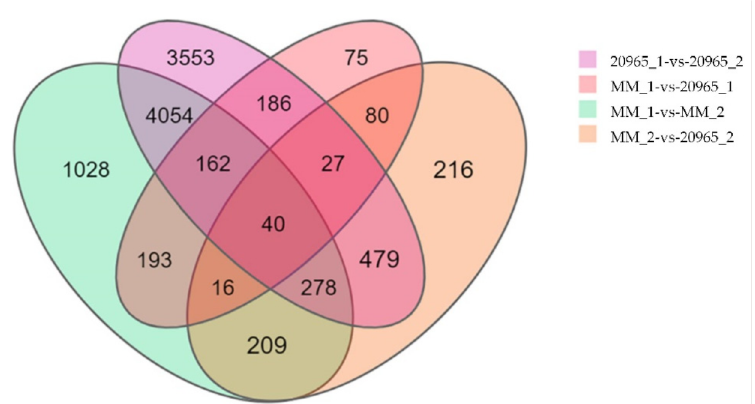
Figure 3. Venn diagram of DEGs included in the four groups. The four groups are MM_1-vs-MM_2, 20965_1-vs-20965_2, MM_1-vs-20965_1, and MM_2-vs-20965_2. Each circle represents a group of gene sets. The overlapping area of different circles represents the intersection of these gene sets, that is, the co-expressed genes. Non-overlapping parts indicate the uniquely expressed genes. The numbers on the figure represent the number of DEGs in the corresponding area.